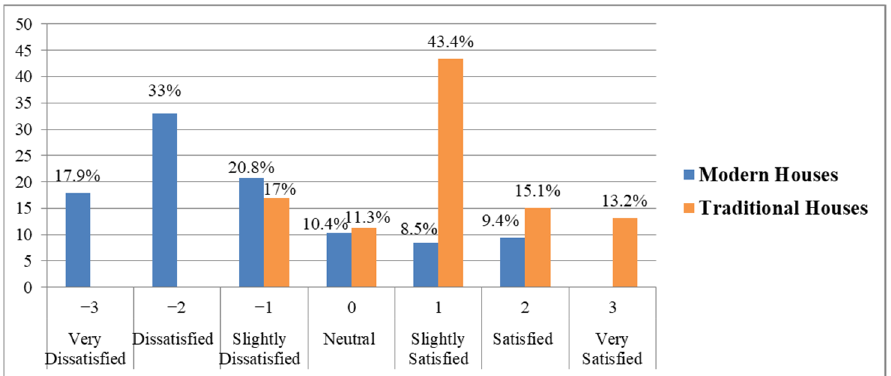
Figure 21. Thermal satisfaction scales for condominium and traditional houses .